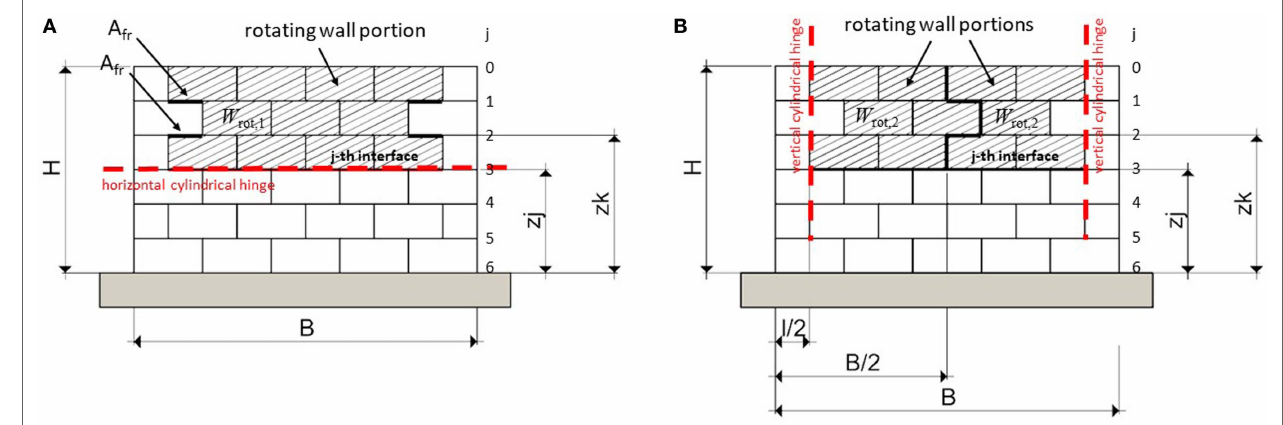
FIGURE 8 | (A) First out-of-plane mechanism. (B) Second out-of-plane mechanism.